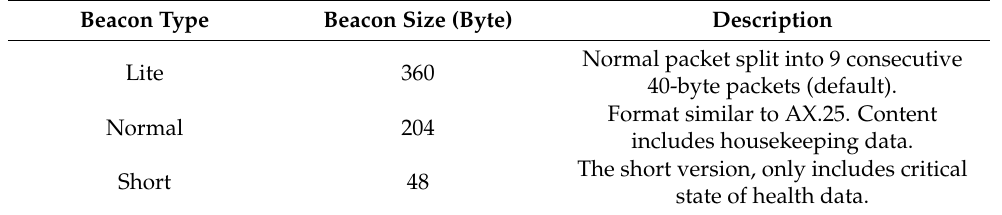
Table 3. IDEASSat beacon